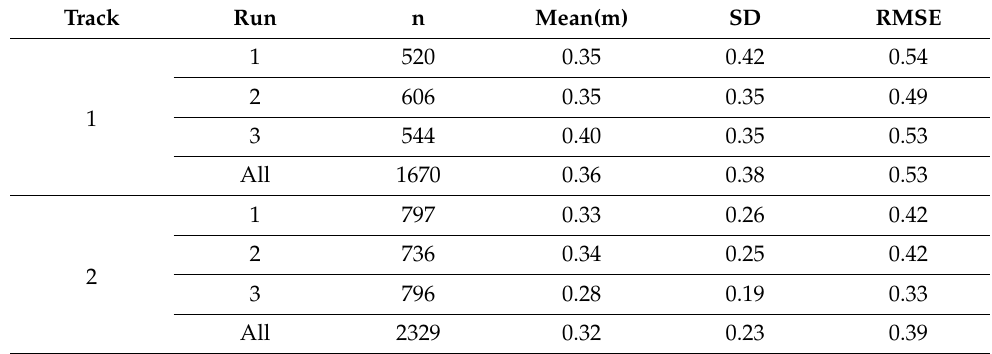
Table 5. Errors between automatic localization and manual measurements presented as means and standard deviations (SDs) of absolute values and as root mean square errors (RMSEs) in meters. Track Run n Mean(m) SD RMSE 1 520 0.35 1 1670